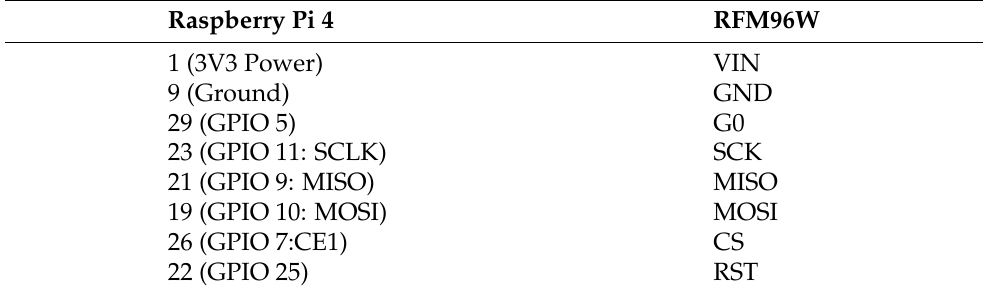
Table 1. Wire connection of the